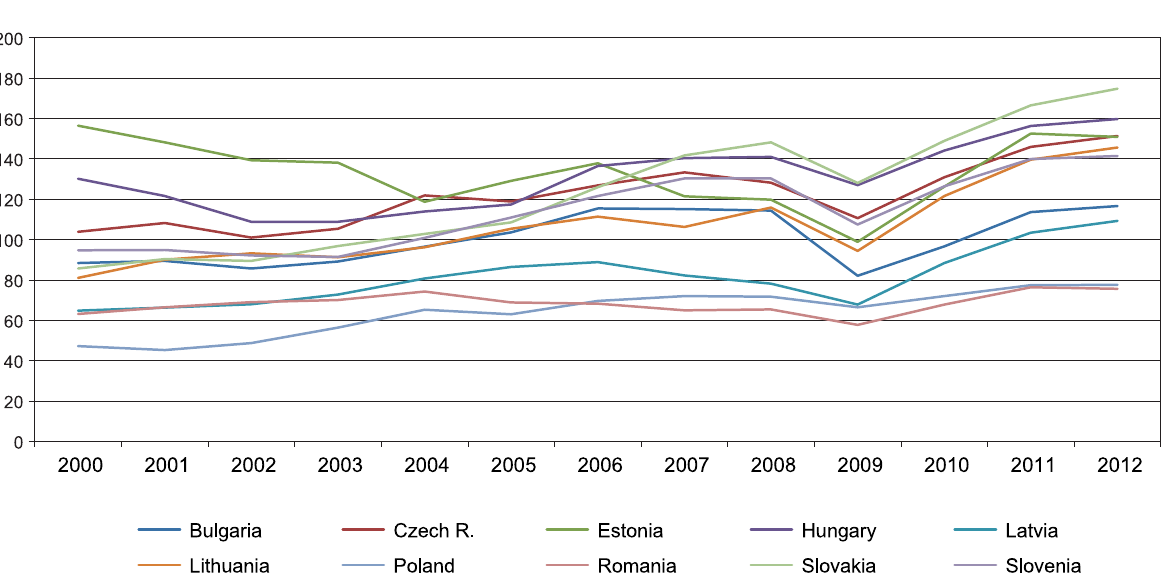
Fig. 3. The current account balance as the share of the GDP, the years 2000–2013 (%). Source: developed by the authors on the basis of the OECD-WTO